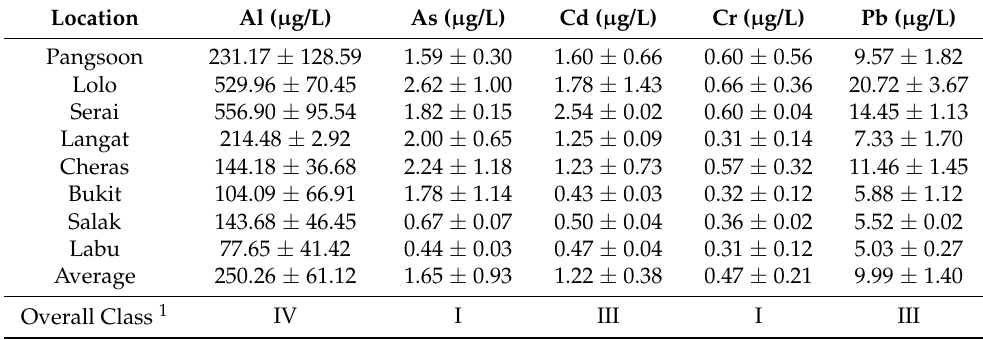
Table 2. Determined metal’s status in Langat River (2015) (n =